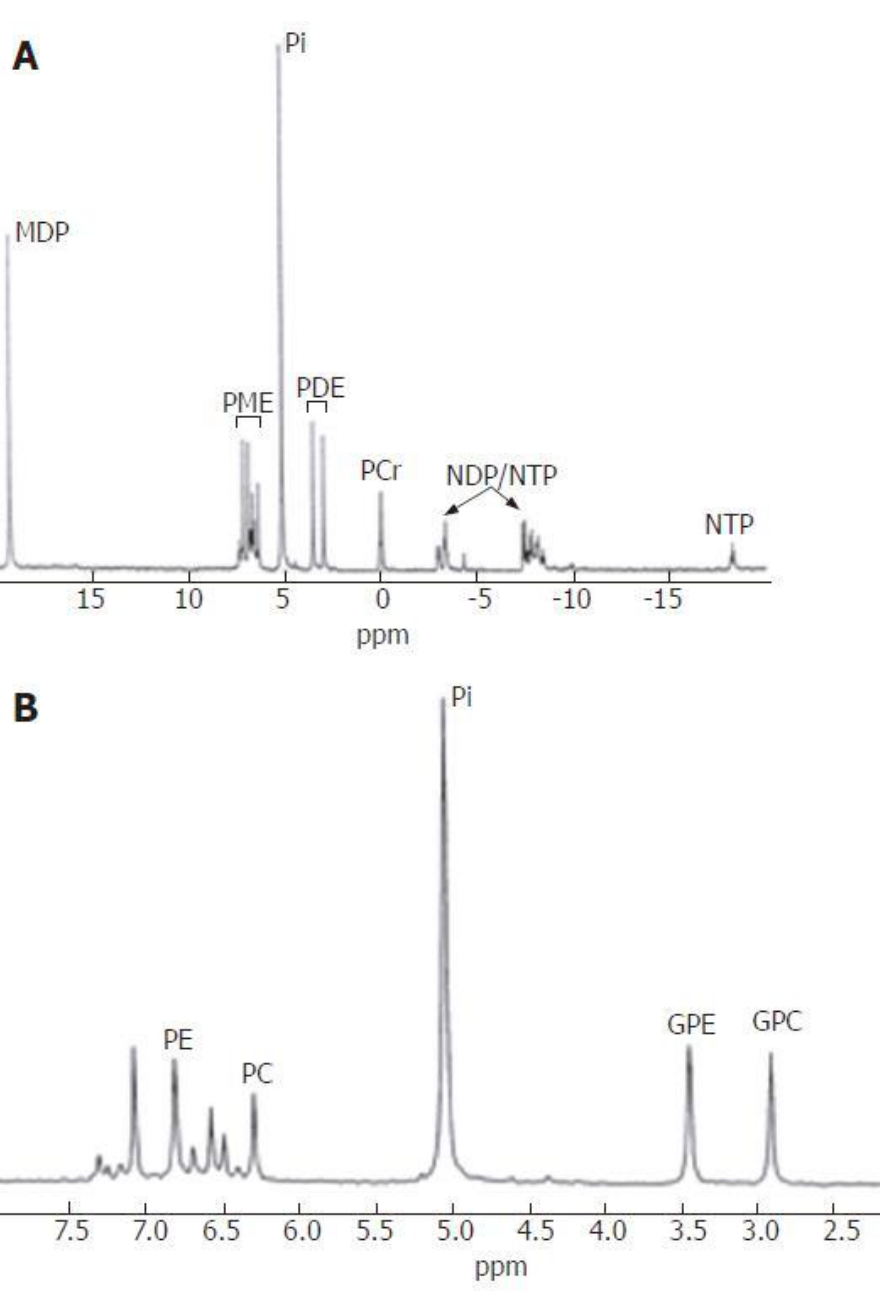
Figure 1. Typical proton-decoupled in vitro 31 P-NMR spectrum of perchloric acid-extracted normal liver tissue. ( A ): Full spectrum; ( B ): PME and PDE regions. NDP: nucleotide diphosphates; MDP: methylene diphosphonate (chemical-shift reference compound); other abbreviations: see text.